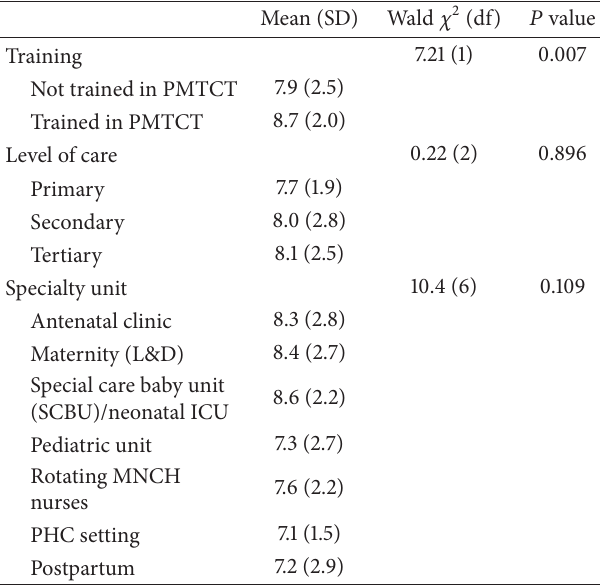
Table 4: PMTCT care practice scores by training, level of care, and specialty unit.